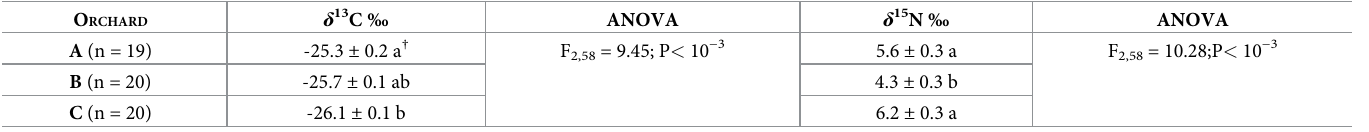
Table 2. Isotopic composition of wild Anastrepha fraterculus flies from three different apple orchards. O